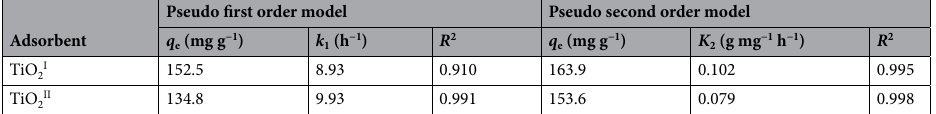
Table 3. Kinetic parameters for Tl(I) adsorption on the TiO 2 I and TiO 2 II fitted with the pseudo first order and pseudo second order